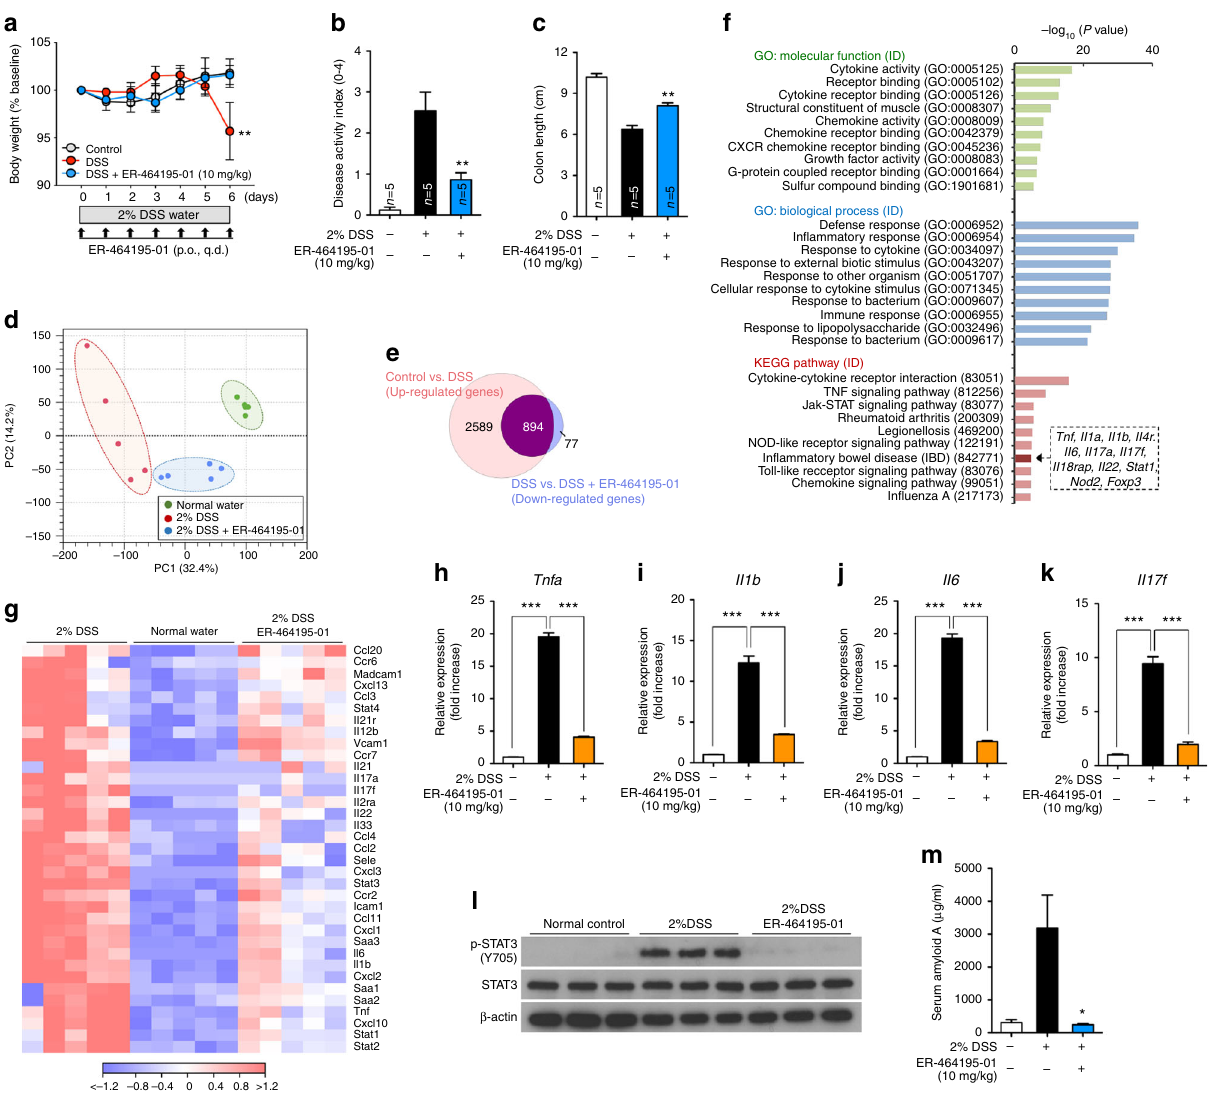
Fig. 3 ER-464195-01 prevents colitis and downregulates the expression of in fl ammation-related genes in DSS-treated mice. a – c Preventing colitis of DSS- treated mice in the prophylactic treatment with ER-464195-01. Body weight a , disease activity index (DAI) b , and colon length c . Results are given as the mean ± SEM of n = 5; ** P < 0.01 versus control group (two-way ANOVA followed by Bonferroni ’ s post test) ( a ), and * P < 0.05 and ** P < 0.01; ER-464195- 01-treated groups versus DSS-treated group at day 6 (two-tailed t test) b , c . d – g , RNA-seq data. Full gene lists are in Supplementary Data 1. Principal component analysis, PC1 ( x -axis, 32.4%) and PC2 (y-axis, 14.2%) of total variation in DEGs d . Venn diagram identifying the intersection (894 genes, magenta) of upregulated gene (DSS alone vs. control group, red) with downregulated genes (DSS with ER-464195-01 vs. DSS alone, blue) (FDR P <